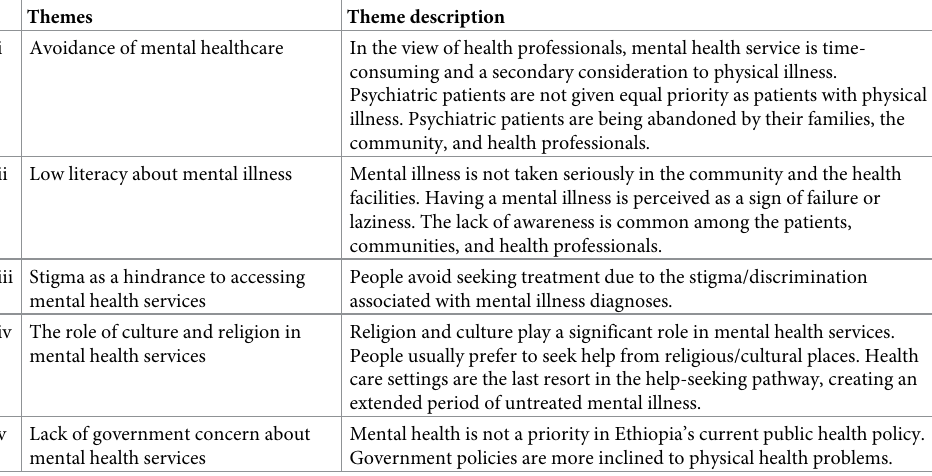
Table 1. Themes with